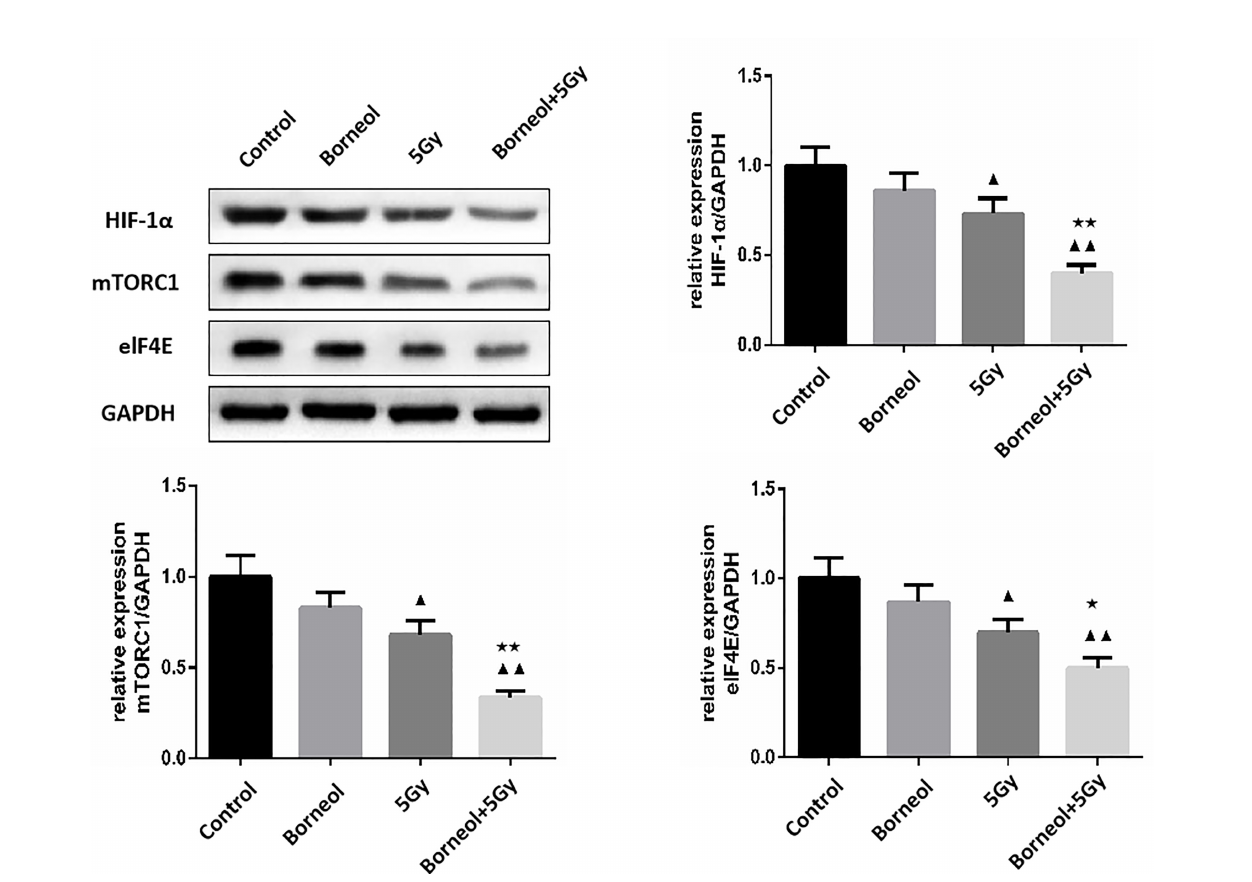
FIGURE 7 | Expression levels of HIF-1 a , mTORC1 and eIF4E in human glioma cells after borneol and radiotherapy treatment( (cid:1) x ± S, n =3). Compared with the control group, ▲ P <0.05, ▲▲ P <0.01;Compared with radiotherapy group, ★ P<0.05, ★★ P< 0.01.